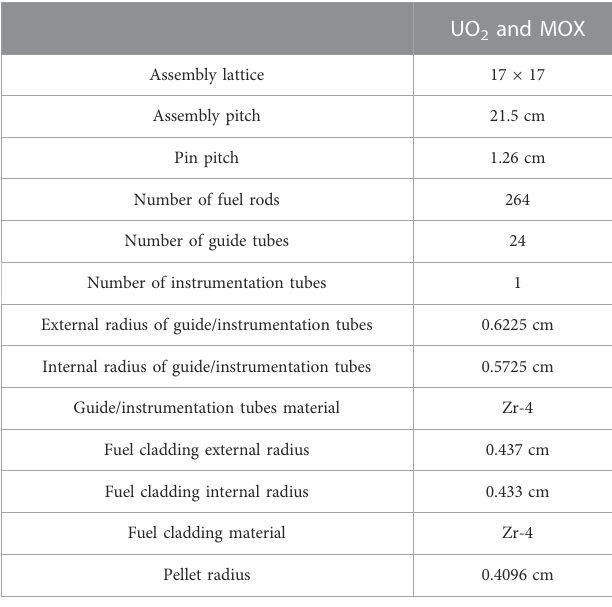
TABLE 3 Geometrical input data for both UO 2 and MOX assemblies extracted from